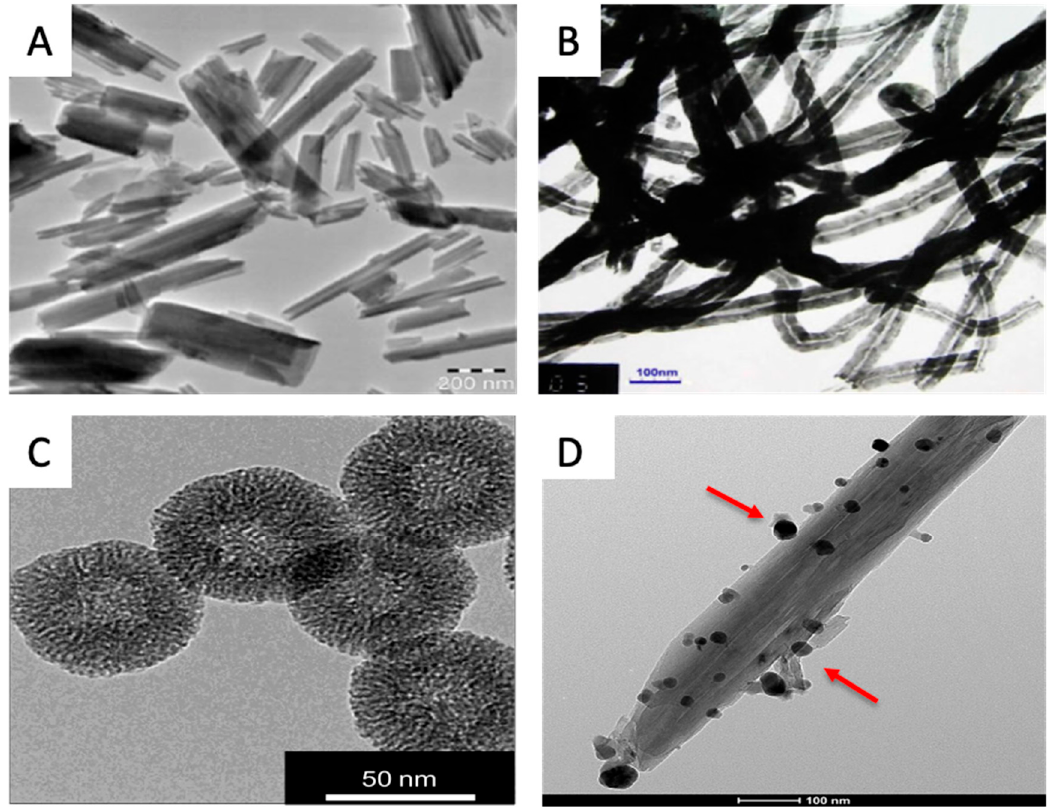
Figure 4. Examples of some representative nanoparticle morphologies. ( A ) halloysite nanotubes; ( B ) carbon nanotubes; ( C ) silica nanoparticles; ( D ) metal nanoparticles. Figures ( B ) and ( C ) are reprinted